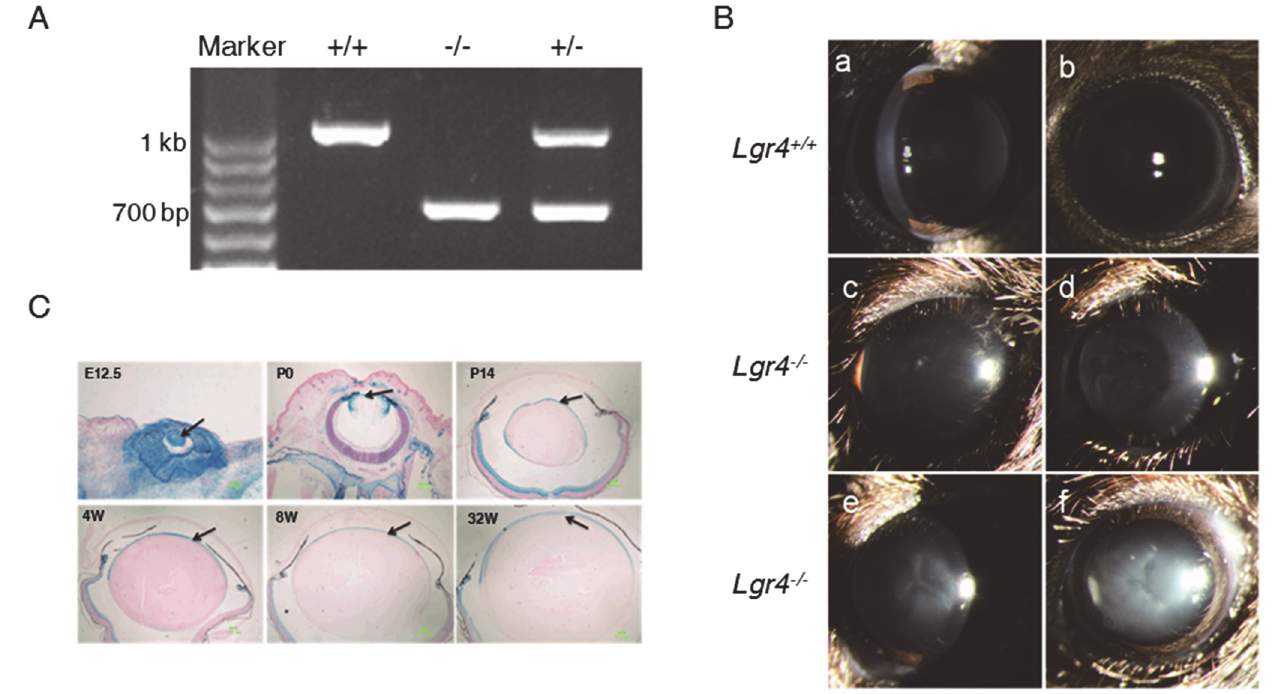
Fig 1. Deletion of Lgr4 in mice causes different types of age-related cataract formation. (A) Disruption of the mouse Lgr4 gene. Genotype analysis of Lgr4 +/+ , Lgr4 − / − , and Lgr4 +/ − mice. +/+, − / − , and +/ − represent genomic DNAs isolated from Lgr4 +/+ , Lgr4 − / − , and Lgr4 +/ − mice, respectively. The 1 kb band is derived from the wild-type allele, and the 700 bp band is derived from the mutated allele. (B) Slit-lamp biomicroscopy examination of wild-type and Lgr4 knockout lenses. At 20 weeks of age, diverse morphologies and various degrees of lens opacification were observed in the anterior portion of the cortex in Lgr4 knockout mice, while most of the wild-type mice remained clear (a,b). Punctate anterior cortical cataract (c). Lamellar cortical cataract (d). The cataract region includes the Y-sutures and looks like a “ fishbone ” pattern (e). The whole lens becomes opaque (f). (C) Expression profile of Lgr4 in mouse lens. LacZ staining of heterozygous lenses showed strong Lgr4 expression in lens epithelial cells from both the embryonic and adult mice at different ages.